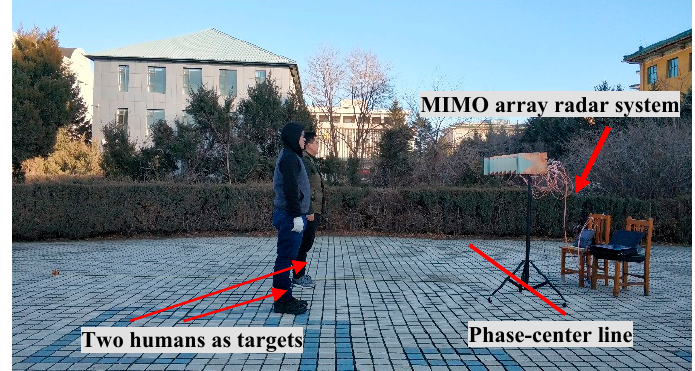
Figure 16. Experiment setup for human imaging.